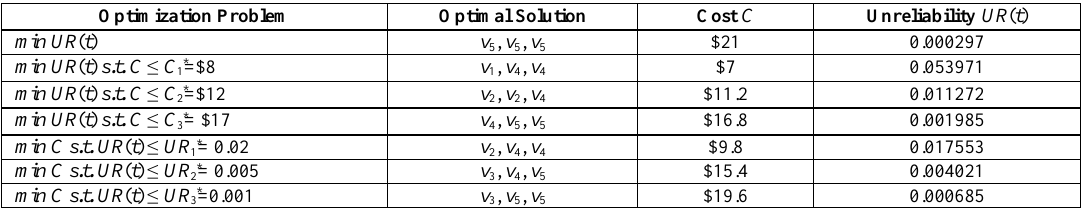
Table 3. Optimal results of 2-out-of-3 with 5 disk